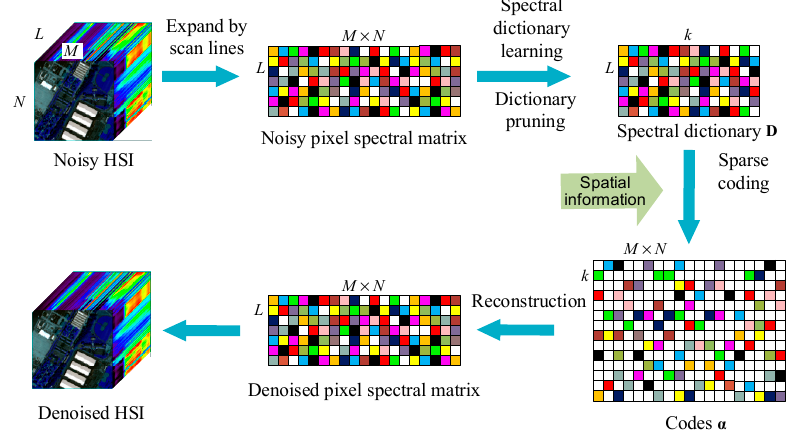
Figure 1. The process of the proposed denoising approach. HSI: hyperspectral image. M is the number of samples in a single scan, N is the scan number in the image, L is the band number, and k is the number of atoms in the trained spectral dictionary. The non-zero elements in the matrix are represented by the color blocks. The white blocks represent the zero elements.